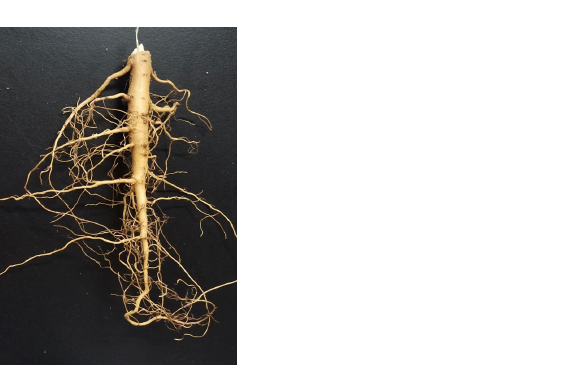
FIGURE 6 Samples of the cotton root system. The root on the left is healthy. The root on the right is affected by the